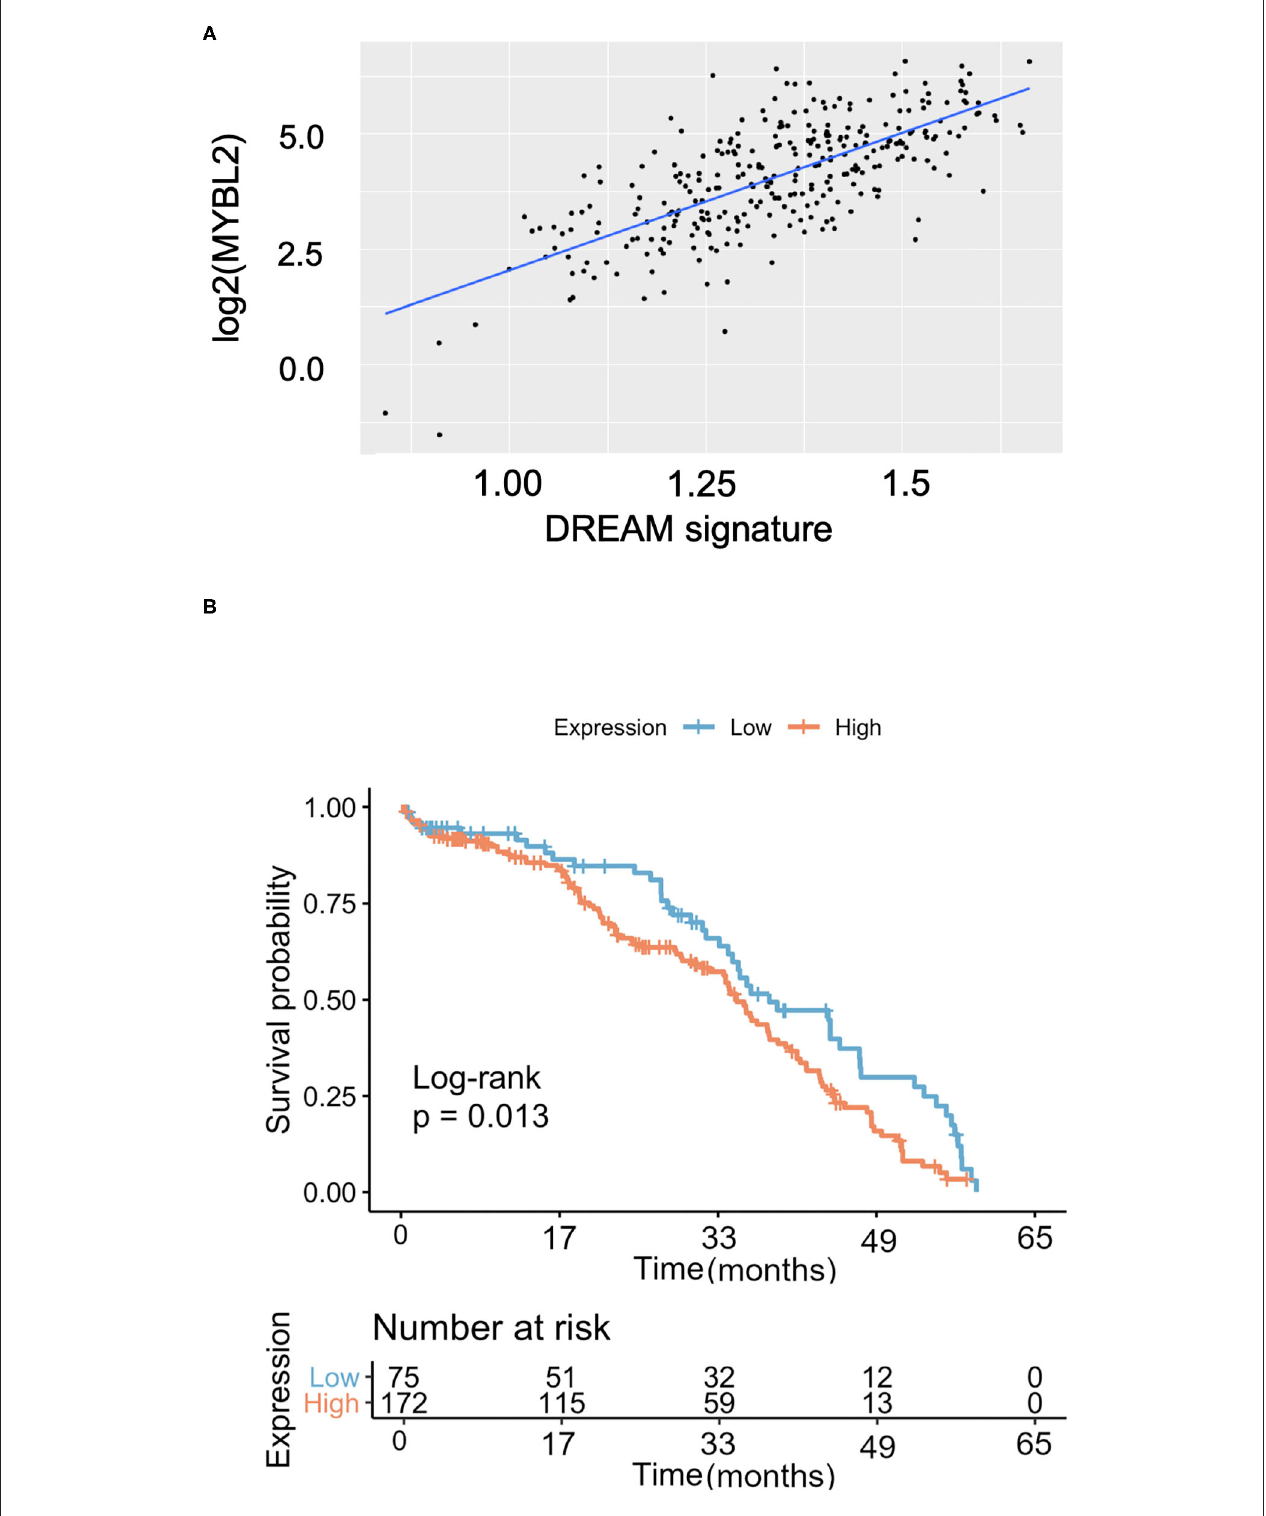
FIGURE 6 | The DREAM transcriptional signature in HGSOC. (A) MYBL2 expression is positively and significantly correlated with global expression of annotated DREAM target genes [as described in Fischer et al. (24) NAR 2016] in TCGA HGSOC samples ( N = 303, Pearson correlation = 0.6, p < 0.0001). (B) Kaplan Meier survival curve according to DREAM transcriptional signature expression ( N =